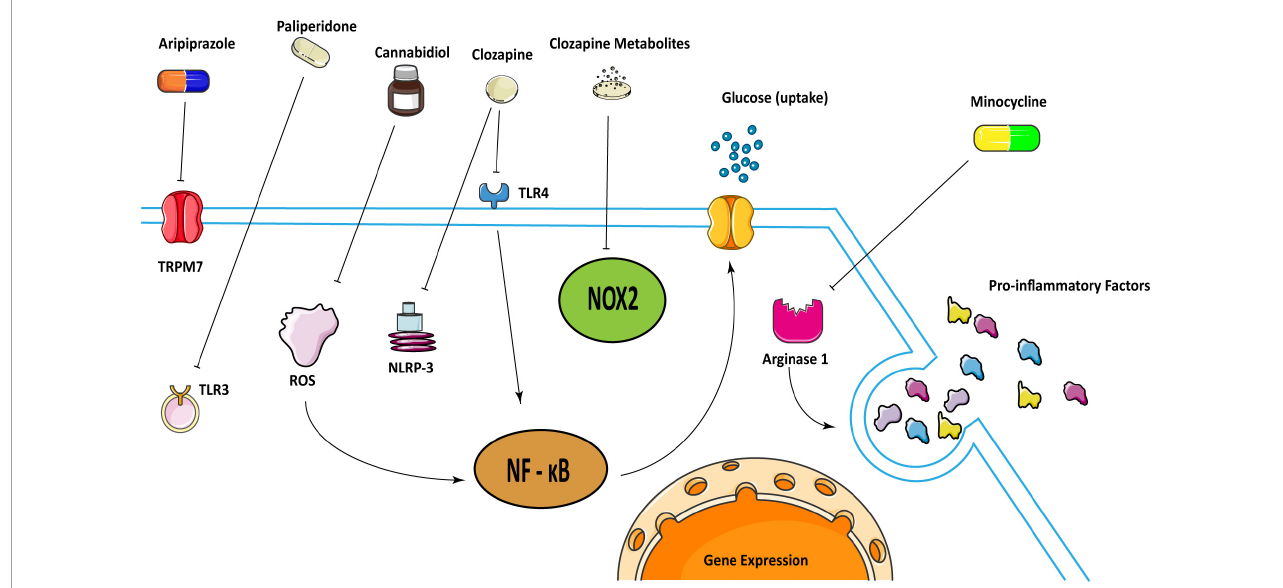
FIGURE1 Schematic illustration representing how some antipsychotics may treat schizophrenia in regulating microglia. Clozapine can attenuate inflammatory responses by inhibiting the activation of TLR 4/NF- κ B mediated by Ca 2 + /CaM/Akt signal as well as inhibit the activation of NLRP-3 inflammasome. And clozapine metabolites can inhibit NOX2 to inactivate microglia. Cannabidiol may inhibit microglial glucose-uptake by inhibiting ROS/NF- κ B-dependent signal transduction to exert anti-inflammatory effects. Aripiprazole can inhibit microglia activation through TRPM7, and paliperidone can achieve the same result through TLR3. Besides, minocycline could reduce pro-inflammatory factors through arginase 1.